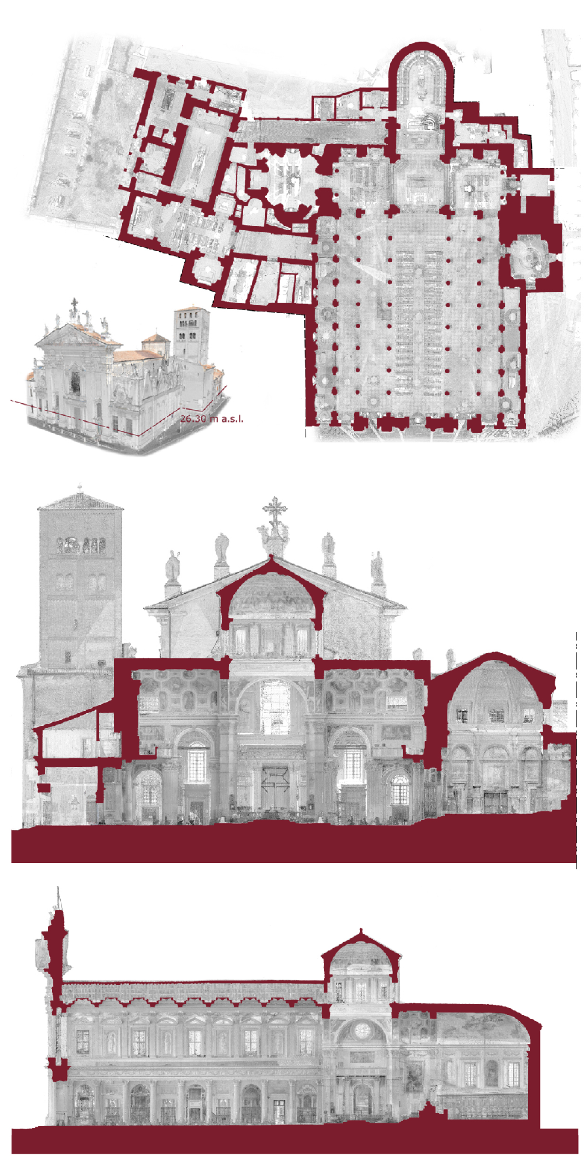
Figure 2. Some of the deliverables of Mantua Cathedral survey obtained from the pointclouds. Top: main plan and perspective external view. Middle: east-west transversal section. Bottom: north-south transversal